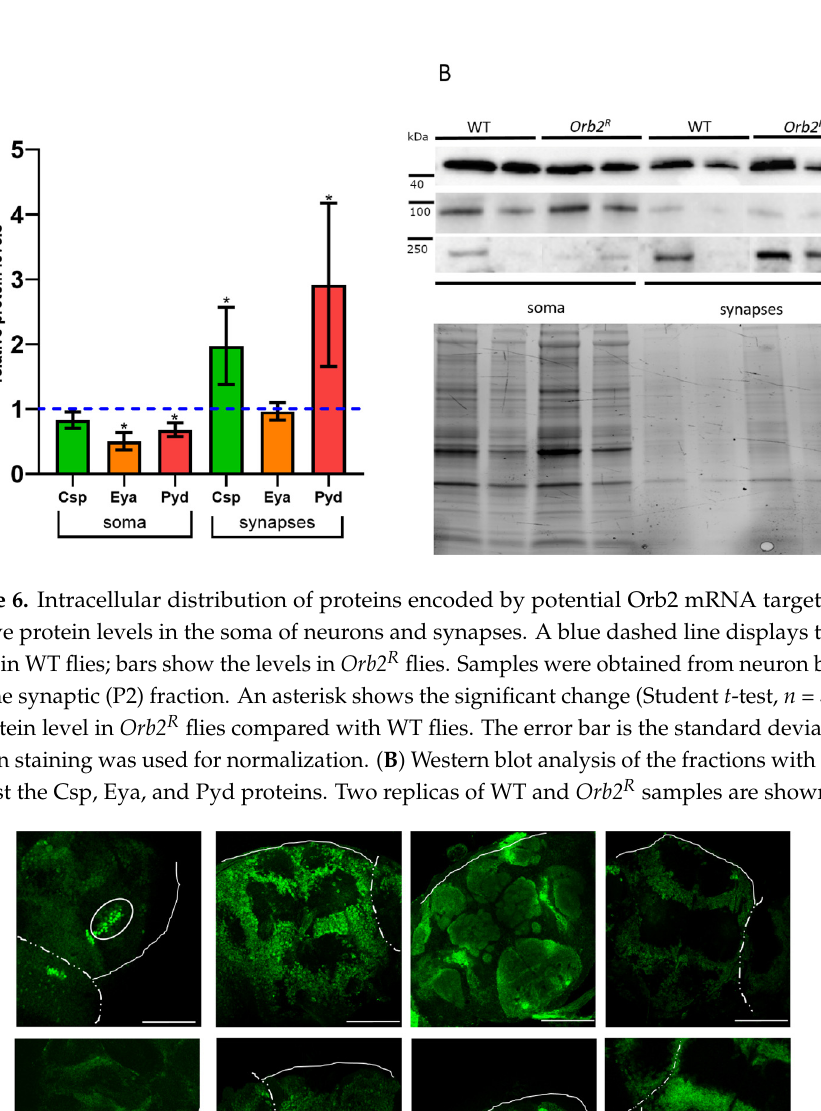
Figure 7. Whole-mount staining of the Drosophila brain in WT and orb2 R flies. Staining was per- formed with antibodies against the Eya, Csp, and Pyd proteins. A dashed line shows the board between the optic lobe and the central brain, and a solid line shows the board of the central brain. White ovals show a group of cells whose nuclei were stained with the antibody against the Eya